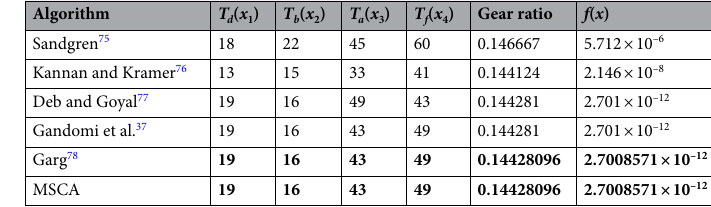
Table 19. The best solution for gear train design problem. Significant values are in bold.